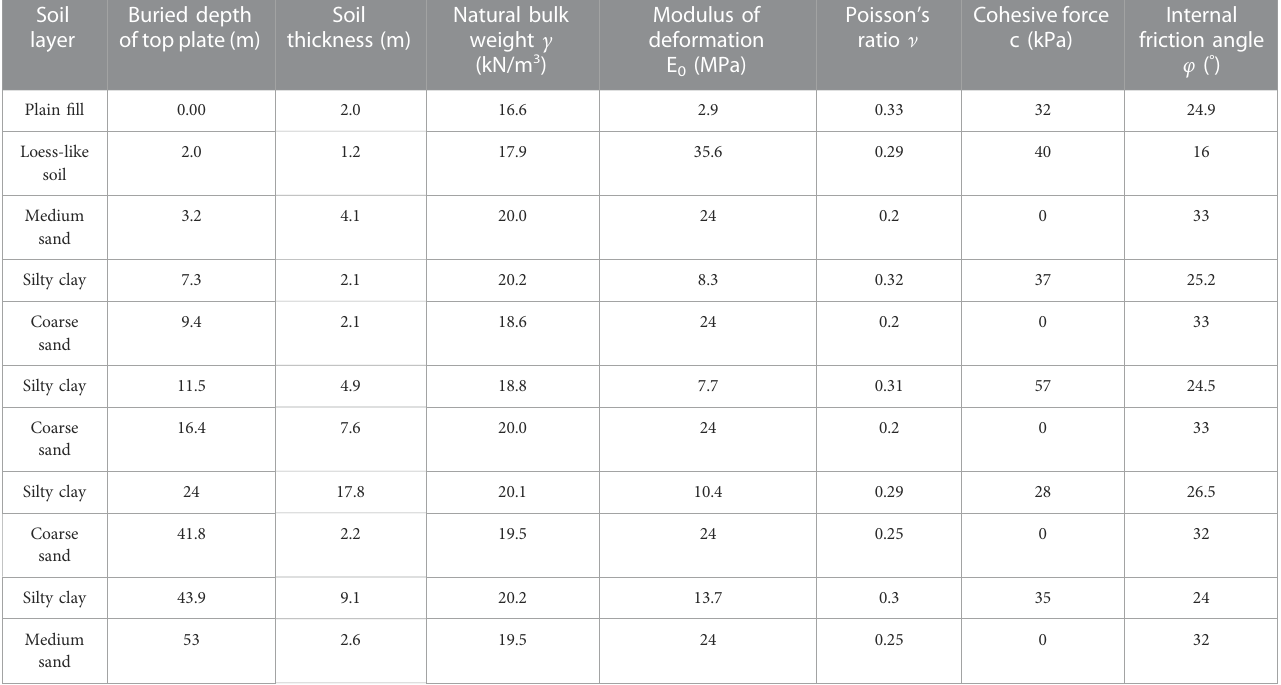
TABLE 4 Soil properties of the fi rst-level alluvial fan. Soil layer